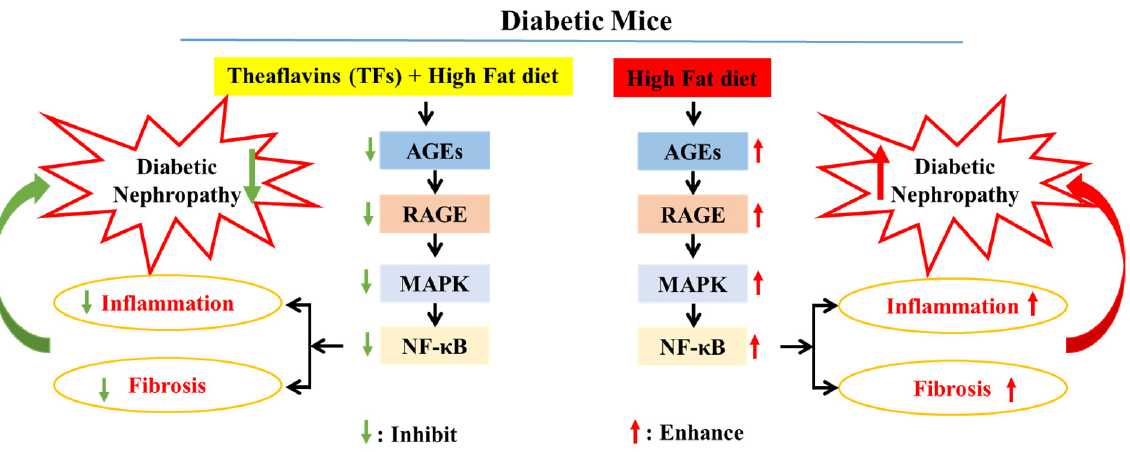
Figure 7. Potential mechanism of kidney injury mediated by AGEs in T2DM mice treated with TFs.